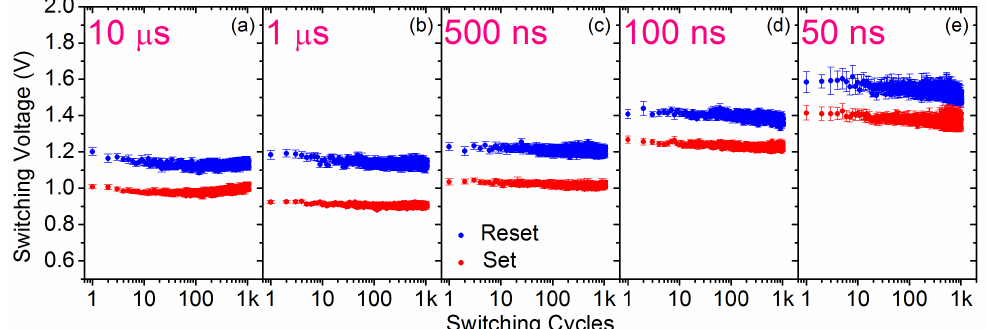
Figure 5. Mean and dispersion values of switching voltages for reset (blue) and set (red) operations during 1k endurance cycles for every programming pulse width: 10 µ s ( a ), 1 µ s ( b ), 500 ns ( c ), 100 ns ( d ) and 50 ns ( e ).